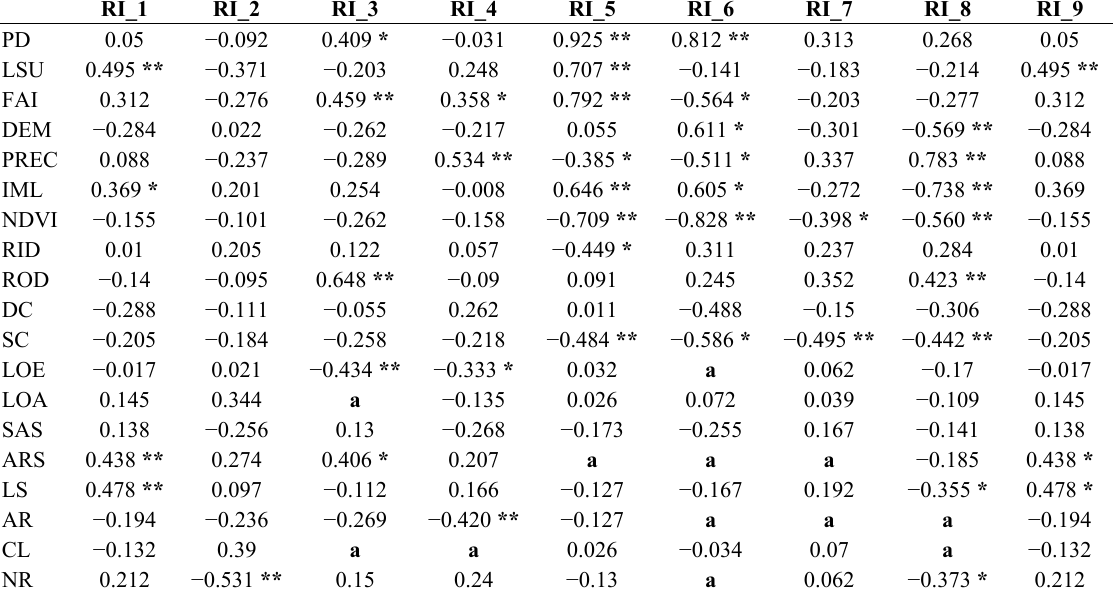
Table 7. Spearman rank correlation coefficient of variables and heavy metal RI to the town-wise data (n = 253) of nine